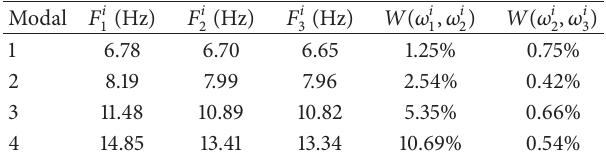
Table 3: Results of updated frequency and 𝑊 ( 𝜔 𝑖 (𝑛−1) ,𝜔 𝑖 𝑛 ); 𝐹 𝑖 𝑛 is the 𝑖 th order frequency under the 𝑛 th updating.